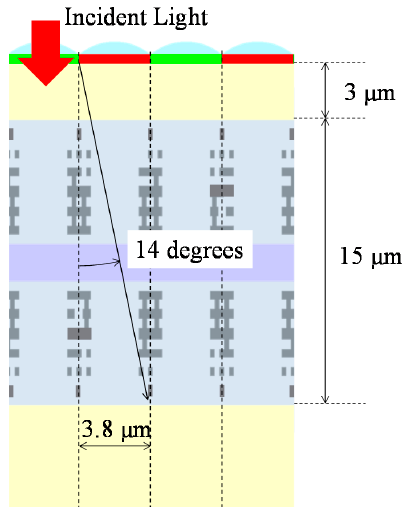
Figure 8. Cross-sectional schematic diagram of the multi-storied PD CIS. Incident light penetrates the top semiconductor layer, the two wiring layers, and the bonding layer and reaches the bottom PDs. Incident light is limited by the wiring layers.